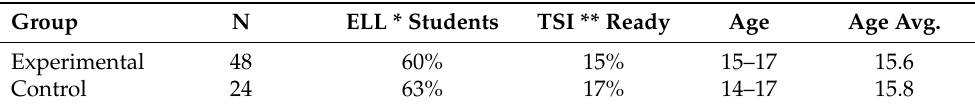
Table 3. Sample group